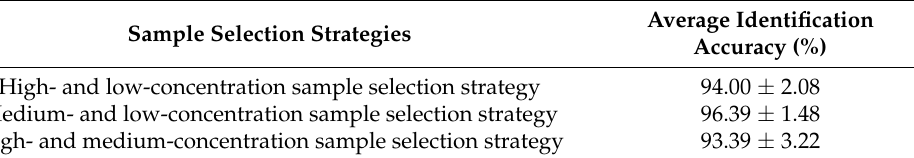
Table 5. Average ethylene gas identification accuracy of WOA-LSTM with compound ethylene concentration sample selection strategies. The training samples were selected from high- and low- concentration, medium- and low-concentration, or high- and medium-concentration ethylene